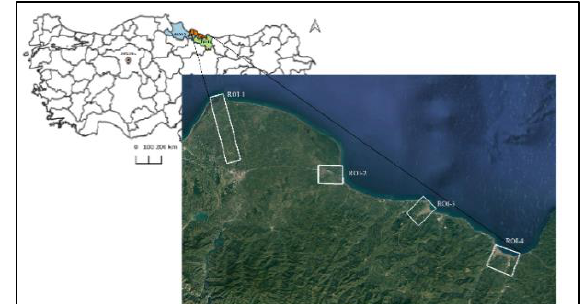
Figure 1. Location of the study area and sub-areas used for evaluation of the resulting flood map (study area coordinates: upper left: 36  35’13” E, 41  25’01” N; lower right: 37  36’11” E, 40  47’45” N).